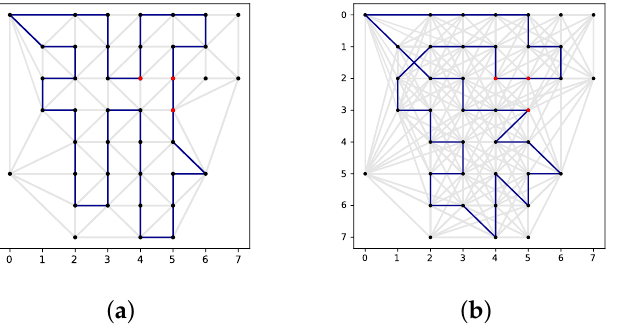
Figure 10. Exact and heuristic solutions to map instance e09dbf . ( a ) Optimal solution. ( b ) GRASP so-